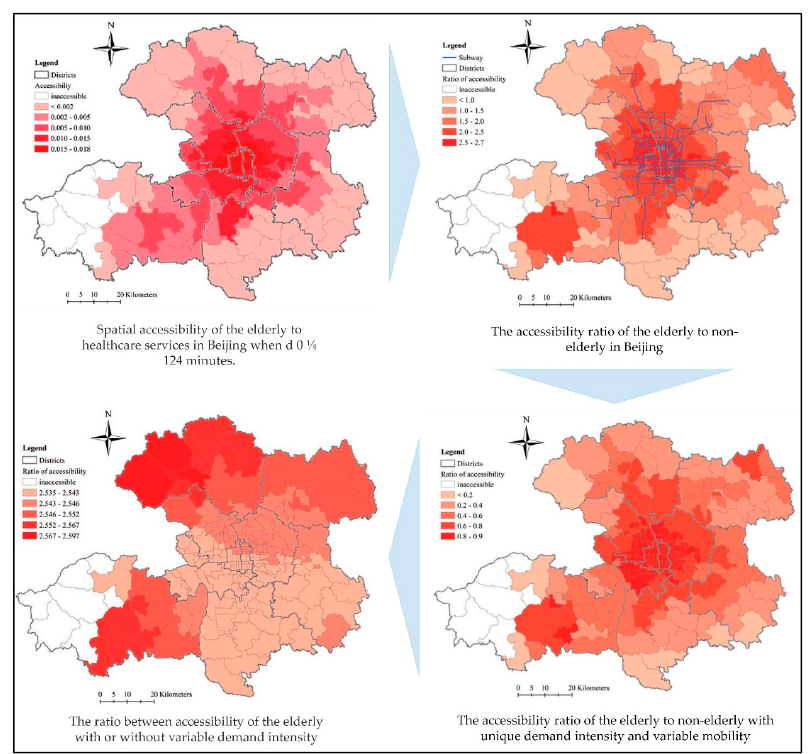
Figure 10. Modeling the spatial accessibility of the elderly to healthcare services in Beijing, China using a multimode and variable-demand two-step floating catchment area (2SFCA) model. (Source: [62]).